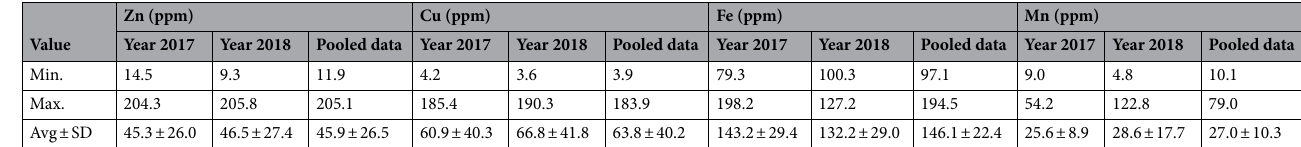
Table 1. Trait variation in the concentrations of seed Zn, Cu, Fe and Mn concentration in the chickpea core set evaluated during the year 2017–2018, year 2018–2019 and data pooled over